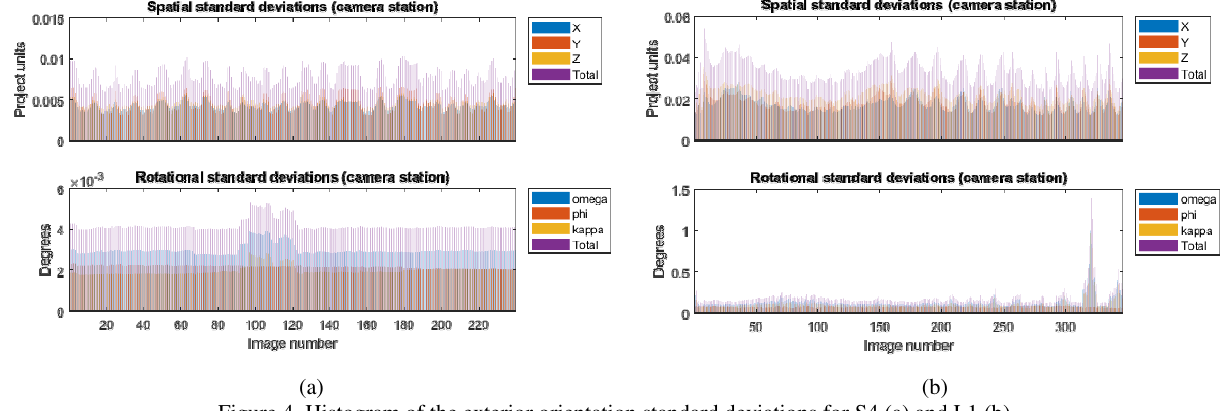
Figure 4. Histogram of the exterior orientation standard deviations for S4 (a) and L1